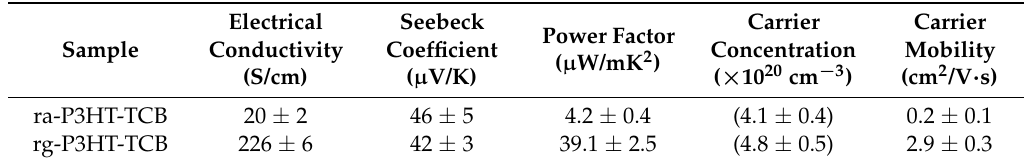
Table 1. Thermoelectric properties, carrier concentration and carrier mobility (hall mobility) of ra-P3HT-TCB and rg-P3HT-TCB.